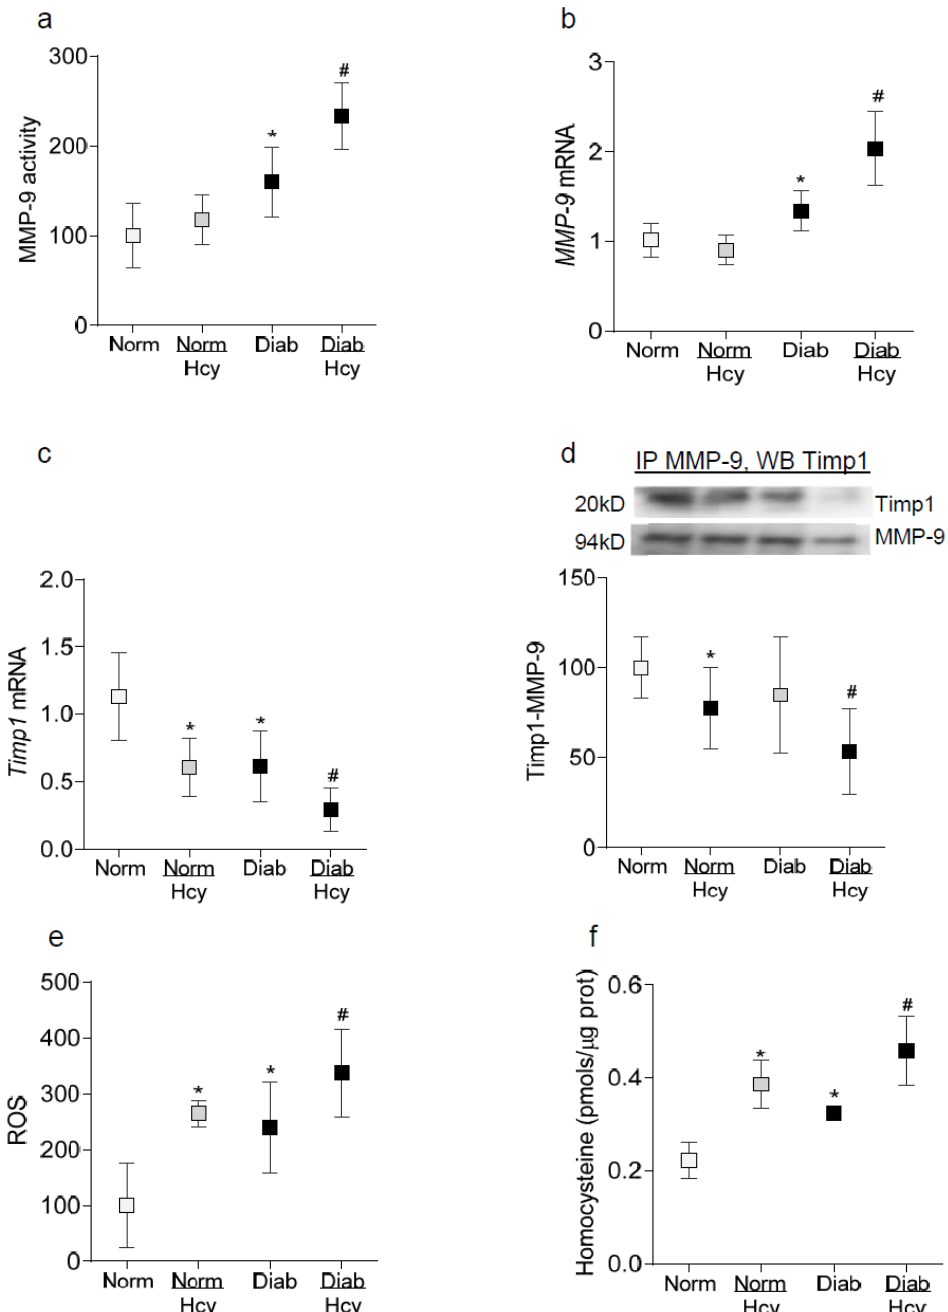
Figure 5. Effect of homocysteine on diabetes-induced alterations in MMP-9, Timp1, Timp-MMP-9 interactions and ROS levels. Retinal microvessels from diabetic rats, with or without homocysteine supplementation were analyzed for ( a ) MMP-9 activity spectrophotometrically, ( b ) and ( c ) MMP-9 and Timp1 gene transcripts by q-RT PCR using β -actin as a housekeeping gene, ( d ) Timp1-MMP-9 interactions by co-immunoprecipitation technique by first immunoprecipitating MMP-9, followed by Western blotting for Timp1, and ( e ) ROS levels fluorometrically using DCFDA. ( f ) Homocysteine levels were quantified in retinal homogenate spectrophotometrically. Each measurement was made in duplicate in 5–7 rats / group, and the values are represented as mean ± SD. Norm and Diab = normal control and diabetes respectively, and Norm / Hcy and Diab / Hcy = normal or diabetic rats receiving homocysteine administration. * p < 0.05 vs. normal and # p < 0.05 vs.